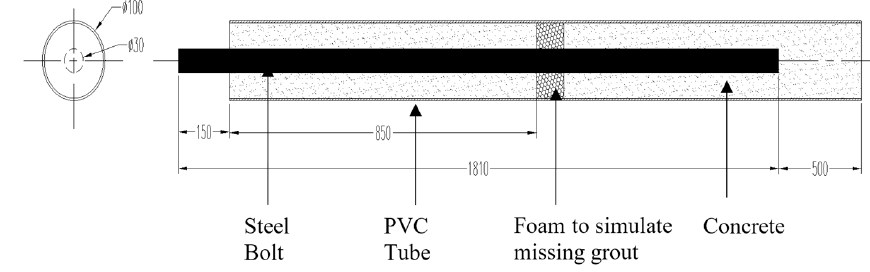
Figure 4. Diagram of the rock bolt specimen.